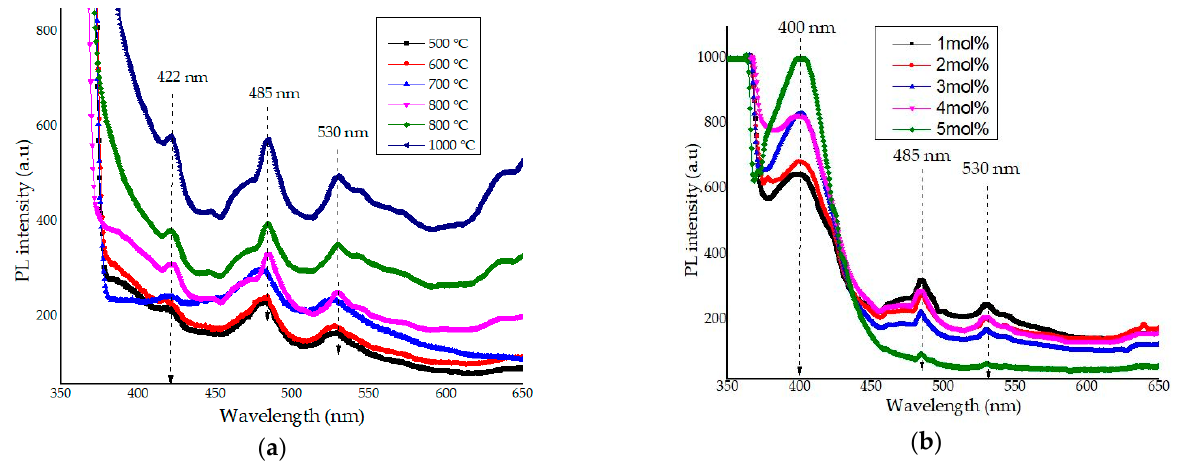
Figure 16. PL emission spectra of ( a ) willemite NPs calcined at different temperatures, and ( b ) willemite doped with different Ce 3+ concentrations calcined at 900 °C.